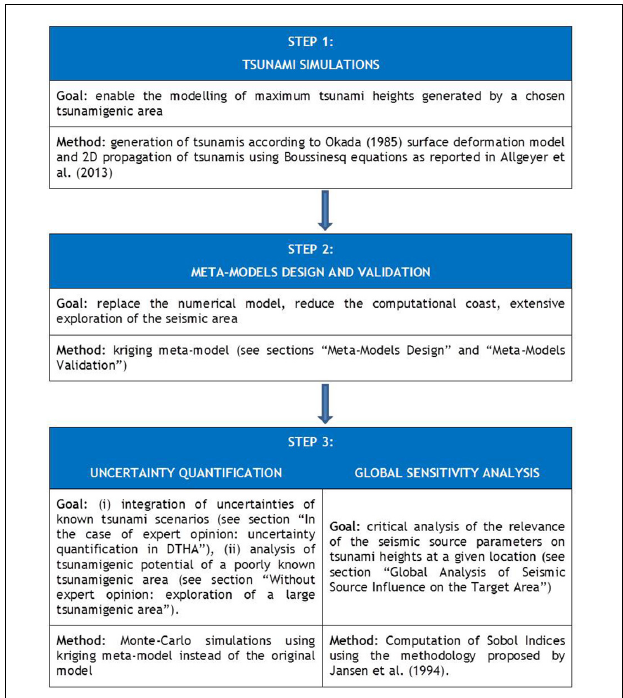
FIGURE 1 | Global methodology proposed in this